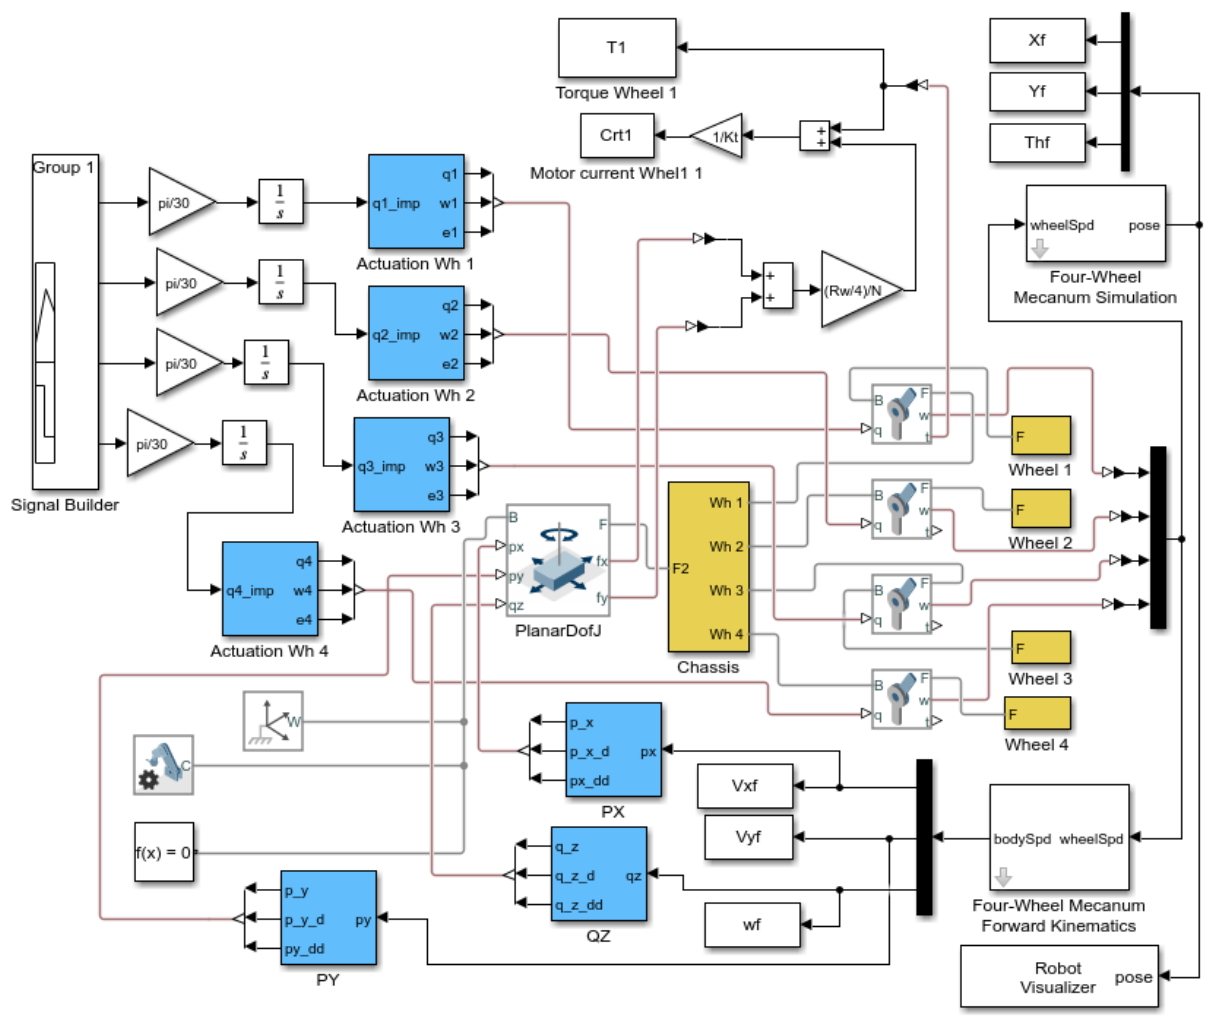
Figure 5. Simulation diagram for the four-wheel Mecanum kinematic solution. Table 8 presents the values of the physical parameters of the system used for the Table 8. Parameters of the system used for the simulation.